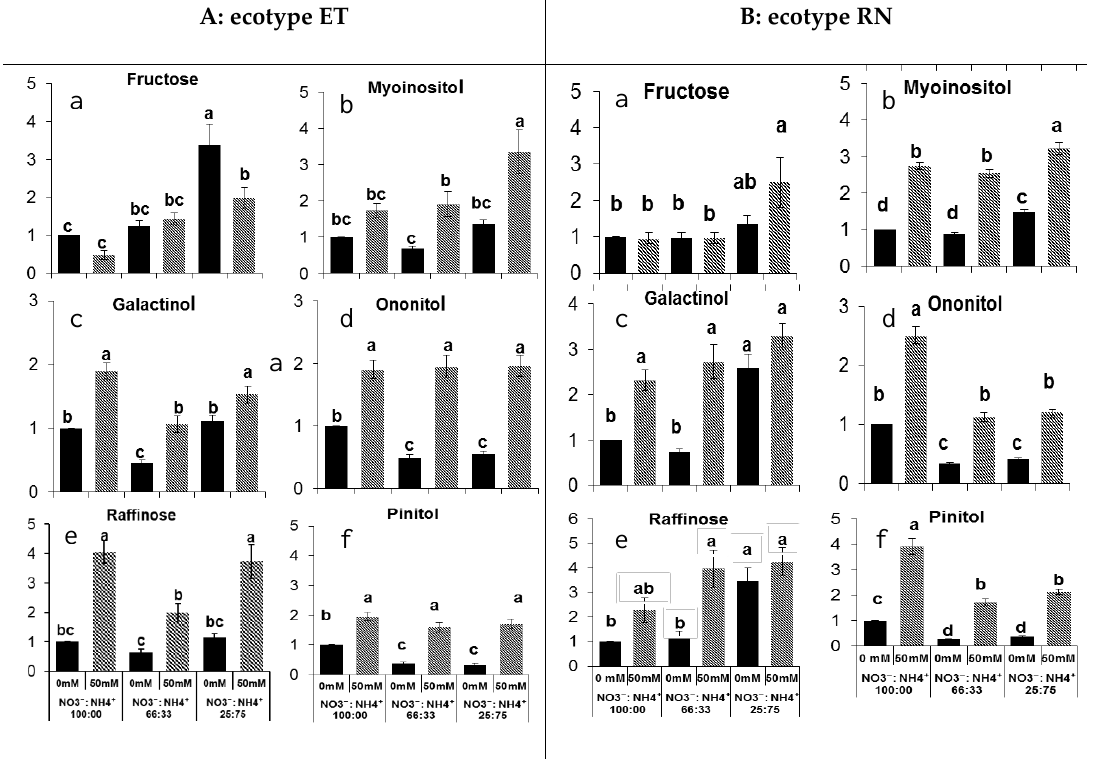
Figure 2. Effect of the nitrate to ammonium ratio (100:00, 66:33, 25:75) and salinity (0, 50 mM) on the sugar accumulation of P. oleracea leaves ecotypes ET (A) and RN (B). The values are means ± SE ( n = 6). Bars with different letters are significantly different between treatments, P ≤ 0.05, as determined by Tukey–Kramer HSD.